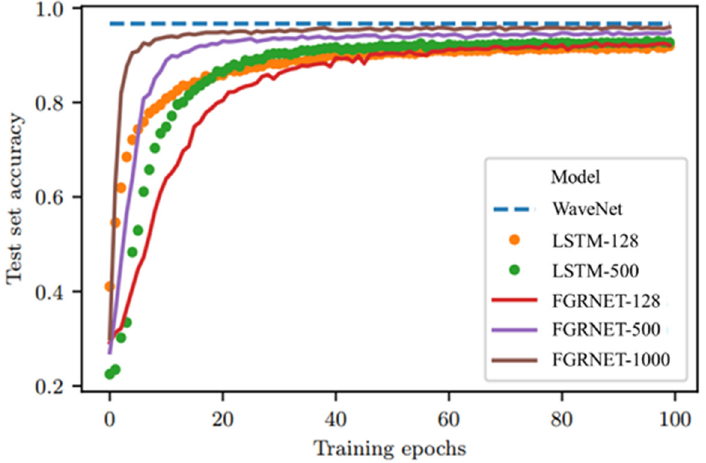
Figure 5. Comparison of classification accuracy of MNIST datasets by different network models (%).